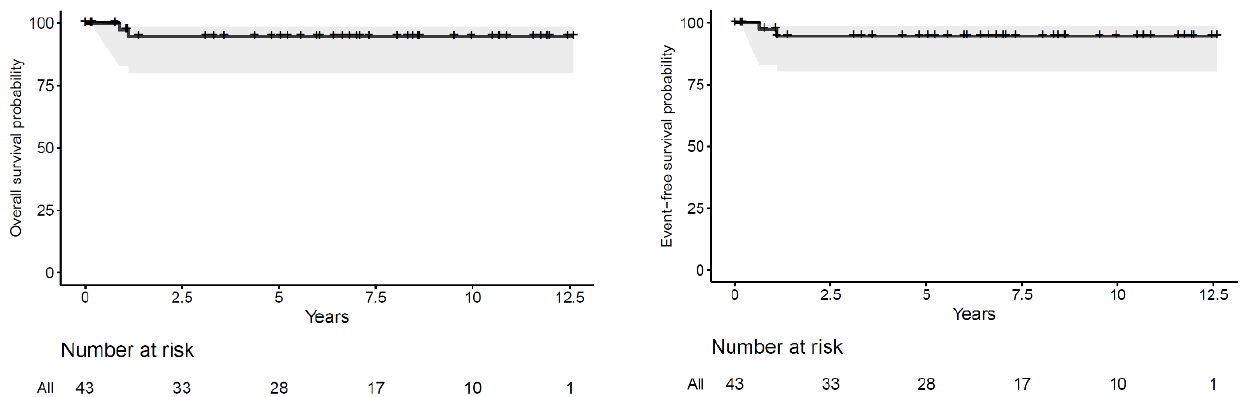
Figure 1. Overall survival (OS) and event-free survival (EFS) for patients with completely necrotic, local stage III, stage IV Wilms tumour. Table 2. Patient and treatment summary.